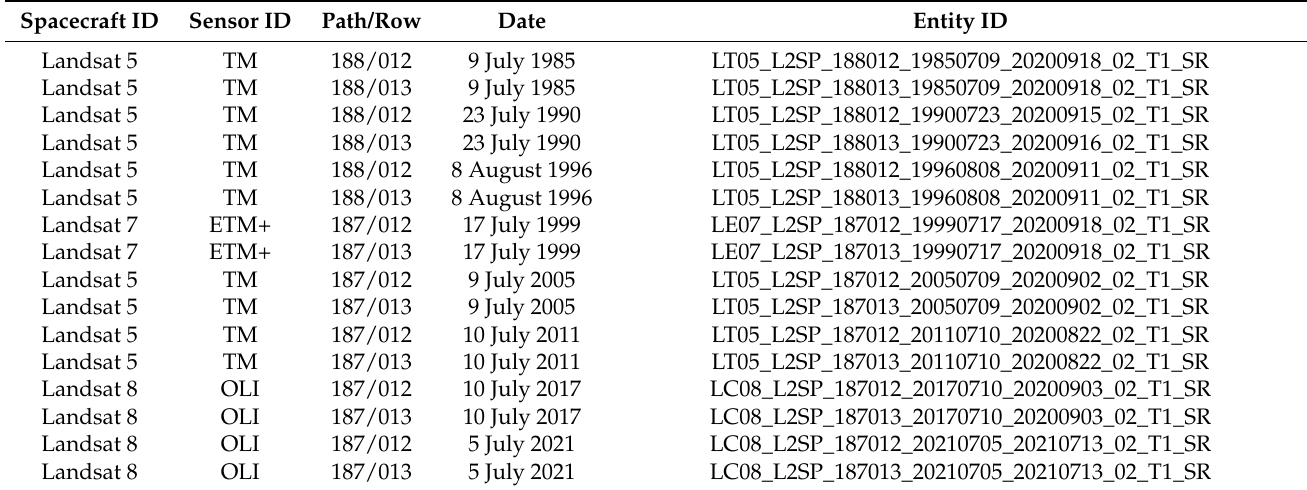
Table 3. Downloaded Landsat product entities used for land cover